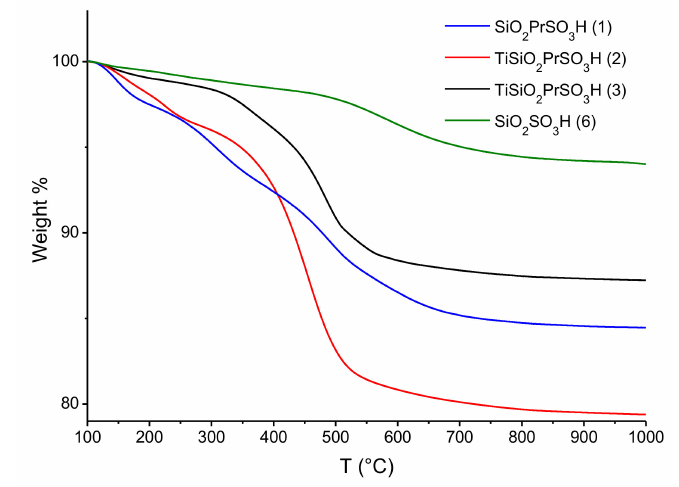
Figure 3. Thermogravimetric curves of sulfonic silica-based